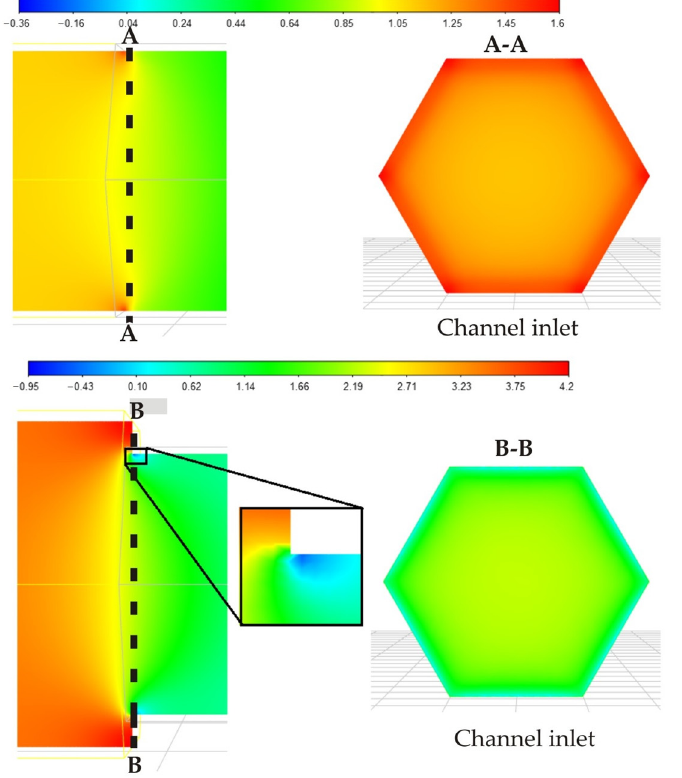
Figure 6. Distribution of static pressure at the channel entrance for simplified ( top ) and real ( bottom ) models ( u 0 = 1 m ∙ s − 1 ).